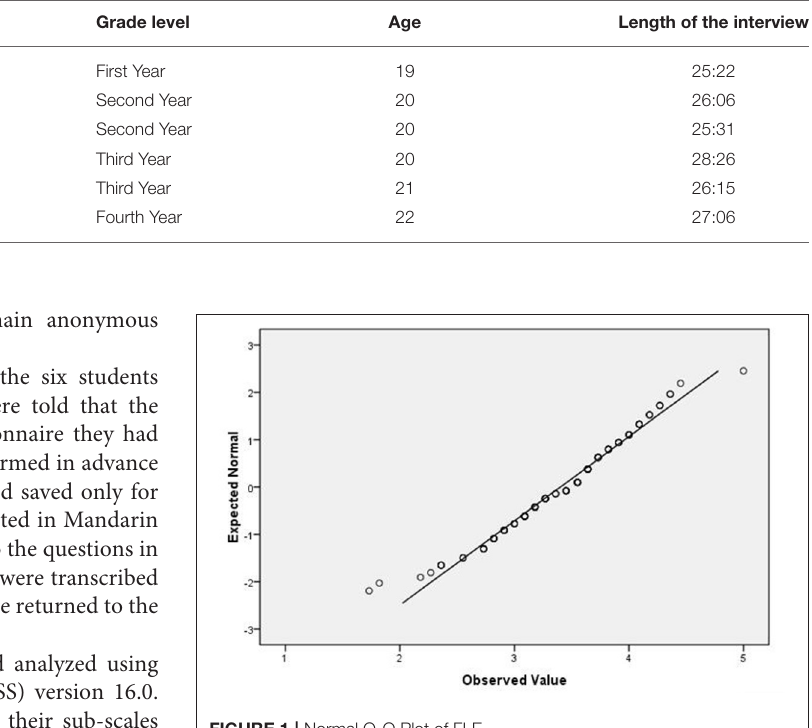
FIGURE 1 | Normal Q-Q Plot of FLE.